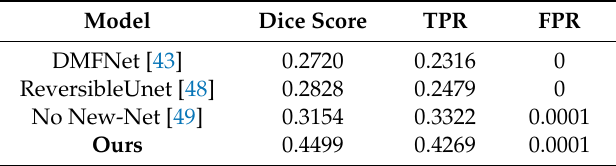
Table 2. The performance comparison of small tumors (tumor volume < 1000 voxels).